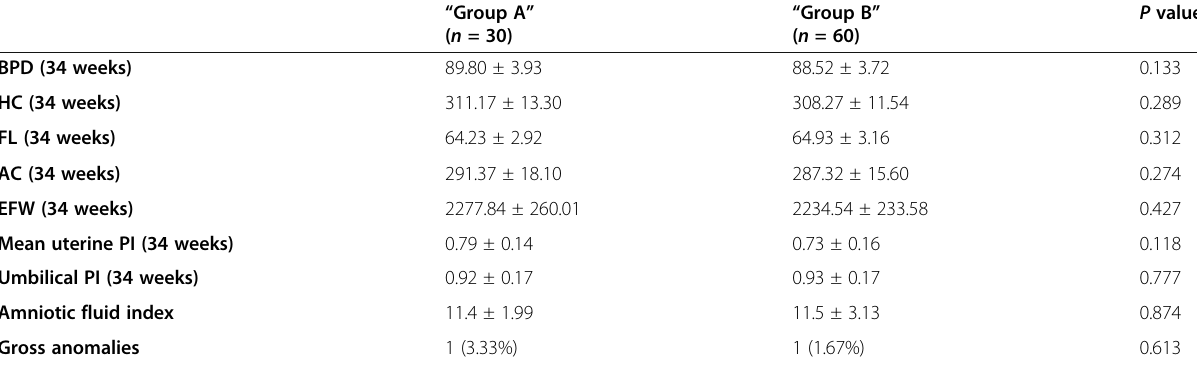
Table 4 Fetal assessment at 34 weeks of gestation in both